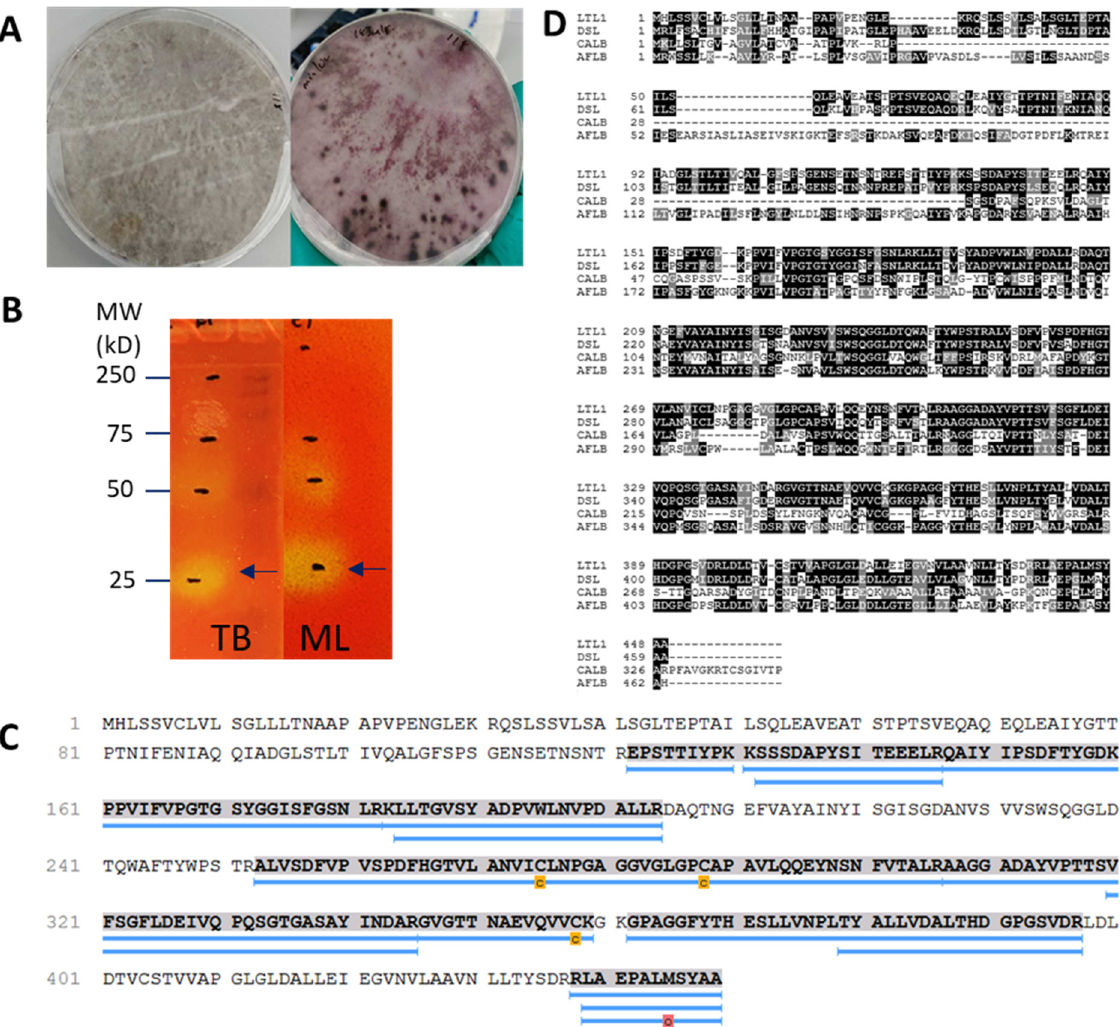
Figure 1. Identification of LTL1 through Zymography-LC-MS. ( A ) Screening of L. theobromae on minimal agar supplemented with 1% v/v olive oil with and 10 µg/mL rhodamine B; ( B ) Zymograms of concentrated L. theobromae culture supernatant developed on chromogenic agar supplemented tributyrin (TB) and monolaurin (ML). Lipolytic activity is indicated by a colouration change in the phenol red pH indicator from red or orange to yellow. Arrow indicates LTL1 excised band from zymography and sequenced with LC-MS. ( C ) Peptide mass fingerprinting alignment with LC-MS achieved 53% coverage from 14 unique LTL1 peptides (post-translational modifications indicated by carbamidomethylation (c) and oxidation (o)) sequenced with LC-MS and aligned to L. theobromae ’s translated genome. ( D ) Multiple gene alignment of LTL1 with lipases identified in Diplodia seriata (DSL), Candida antarctica (CALB) and Aspergillus fumigatus (AFLB).